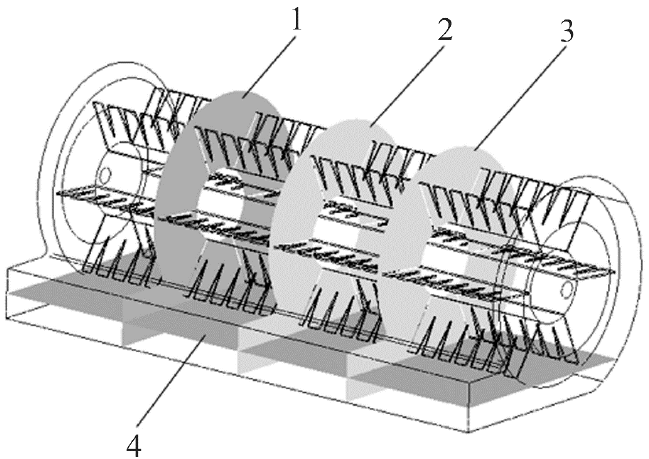
Figure 9. Schematic diagram of cross-section selection.1. Cross section 3. 2. Cross section 1. 3. Cross section 2. 4. Cross section 4.